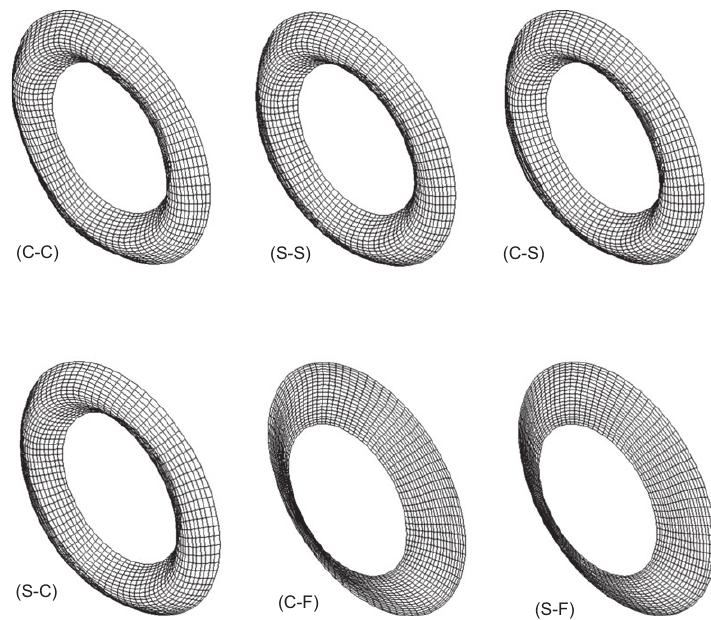
Figure 6 Mode shapes for the laminated annular circular plates (a/b = 0.6).